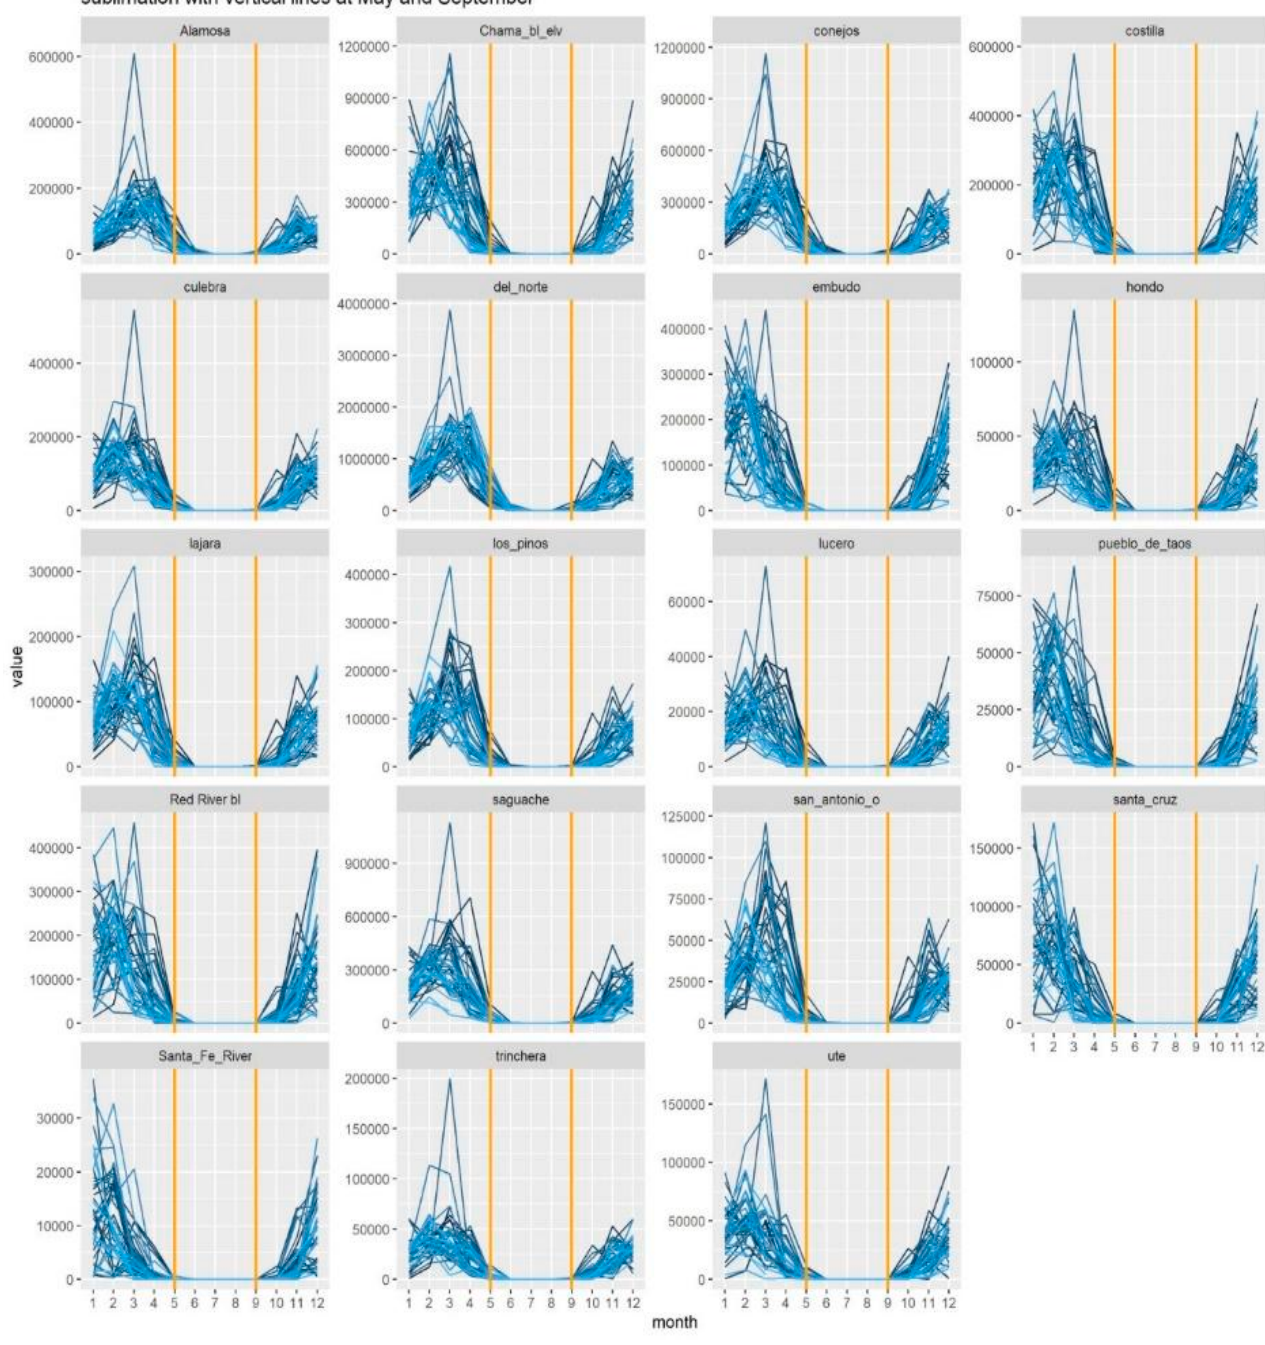
Figure A3. Sublimation in summer months.